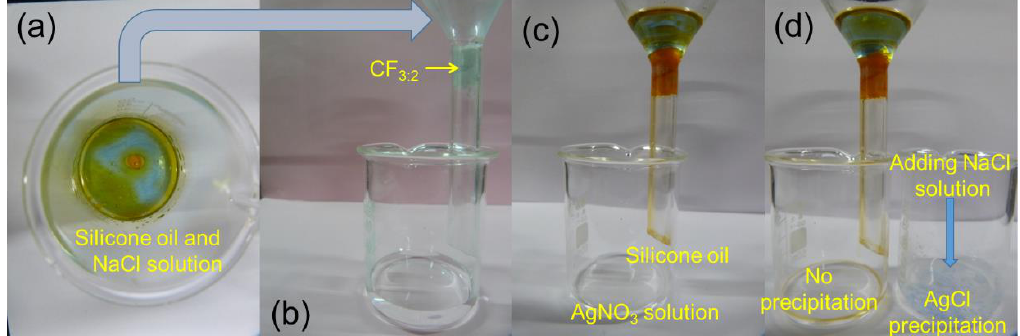
Figure 7. Separation efficiency test of oil absorption by CF 3:2 .